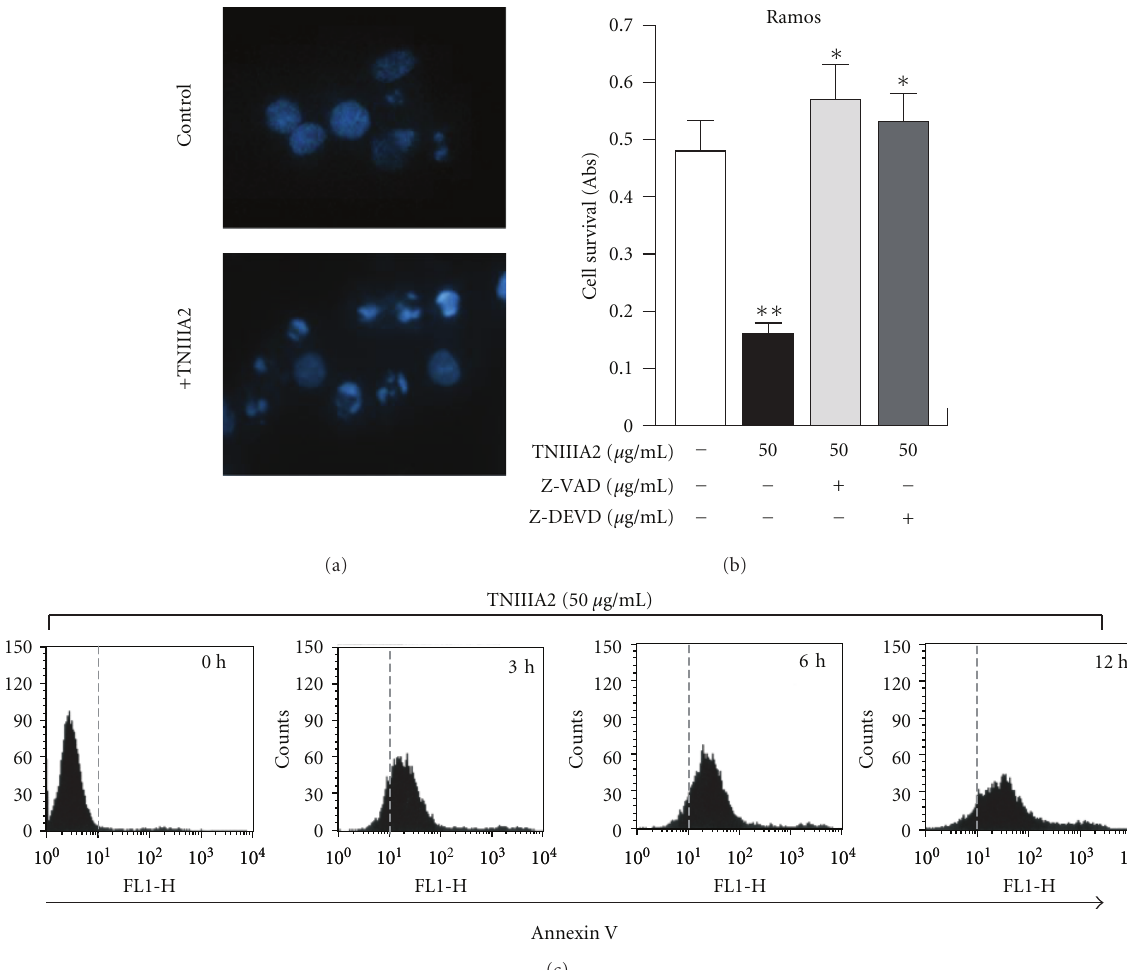
Figure 3: Apoptosis was induced on Ramos cells with TNIIIA2 administration. (a) Hoechst staining of Ramos cells treated with TNIIIA2. (b) E ff ect of caspase inhibitors on Ramos cell survival, treated with TNIIIA2. (c) Cell surface exposure of phosphatidylserine on Ramos cell treated with TNIIIA2 (figures were modified from Figure 2 of [19]). ∗ P < 0 . 05 versus TNIIIA2 single treated sample, ∗∗ P < 0 . 05 versus untreated